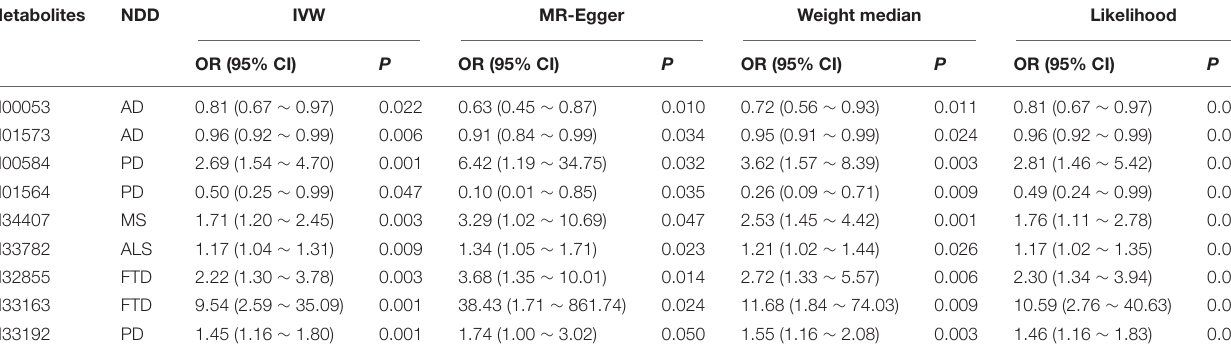
TABLE 3 | Suggestive association metabolites passing all MR analyses at the nomial significance level of 0.05. Metabolites NDD IVW MR-Egger Weight median